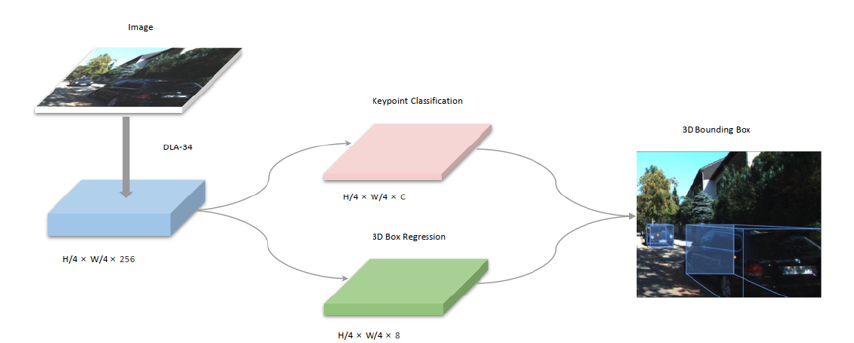
Figure 8. Scheme flow of SMOKE